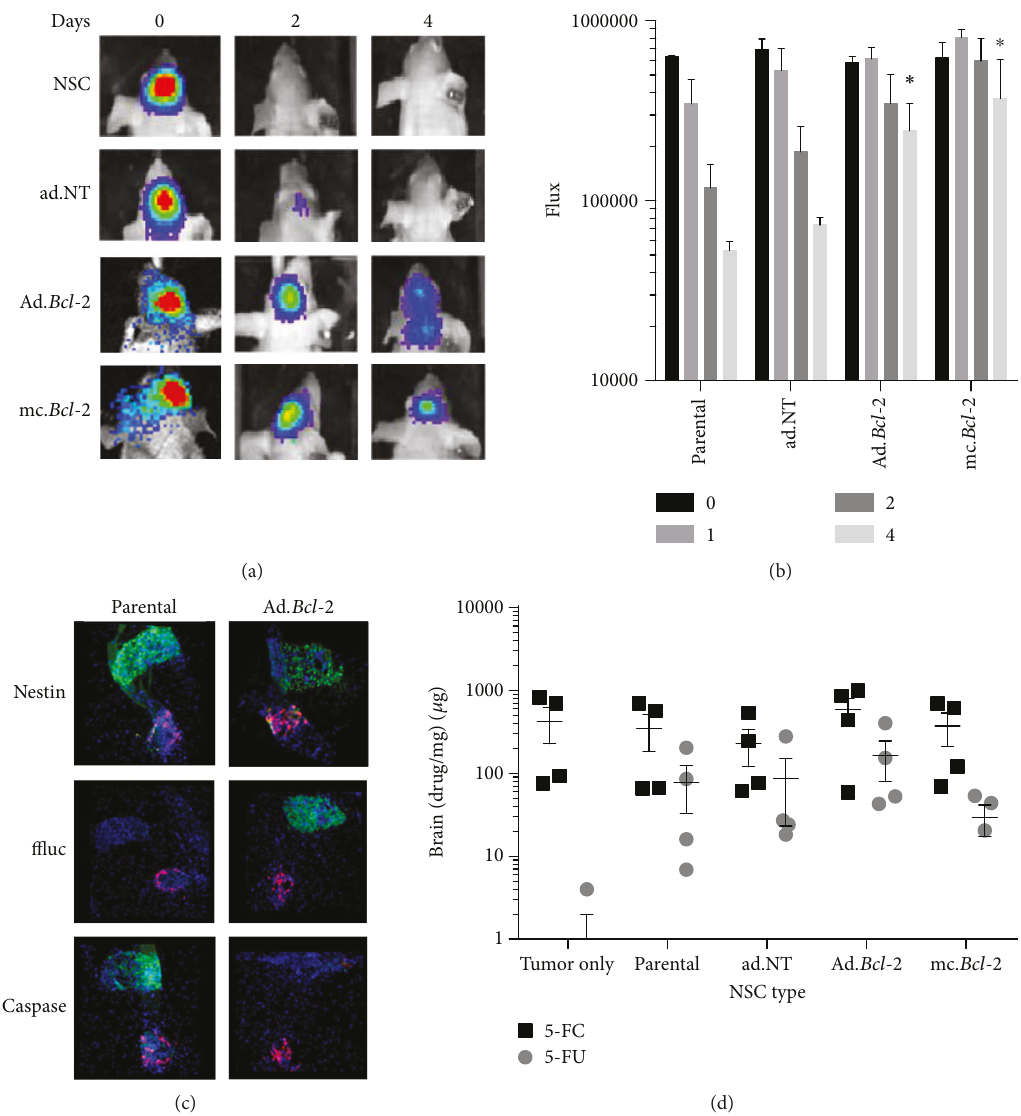
Figure 3: Bioactive e ff ects of Bcl-2 expression in NSCs in vivo . (a – c) NSC survival after ipsilateral transplantation into glioma-inoculated mice. (a) Representative xenogen images of ffl uc-expressing NSCs at select time points. (b) Quanti fi cation of xenogen fl ux in all animals (mean+ SEM) shown at select time points. Asterisks indicate statistically signi fi cant increases in NSC fl ux relative to time-matched parental NSCs ( p < 0 05 ). (c) Representative tissue sections showing DsRed.U251 tumor (red) and NSC (green) injection sites 1 day after NSC injections. NSCs are stained for nestin (present in live and dead NSCs), eGFP (expressed only in live NSCs), and active caspase-3 (expressed only in dying NSCs). (d) LC/MS/MS quanti fi cation of 5-FC prodrug (black) and 5-FU (gray) active drug present in mice brains implanted with both parental and genetically modi fi ed